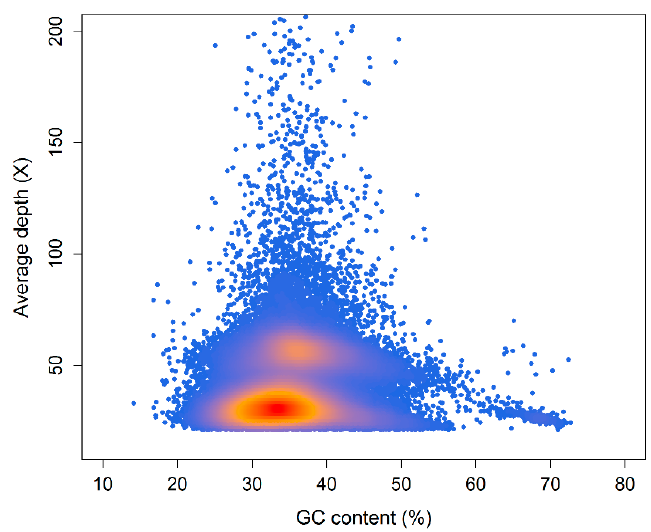
Figure 3. GC depth distribution of B. platyphylla genome (before filtration). The X-axis is the GC content and the Y-axis is the average depth. Each dot represents a contig. Color from red to orange and then to blue indicates dot density from high to low.